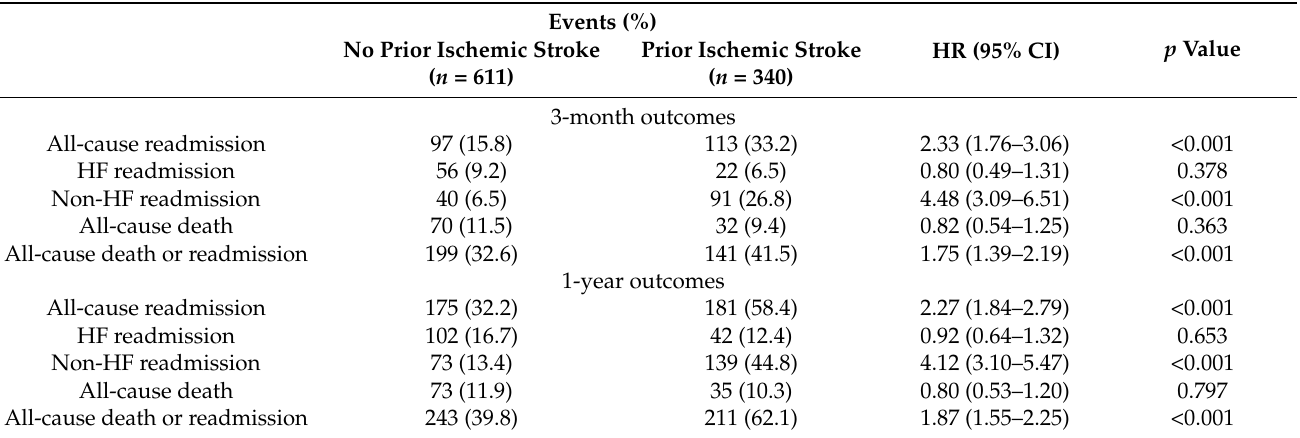
Table 2. Clinical outcomes in the total